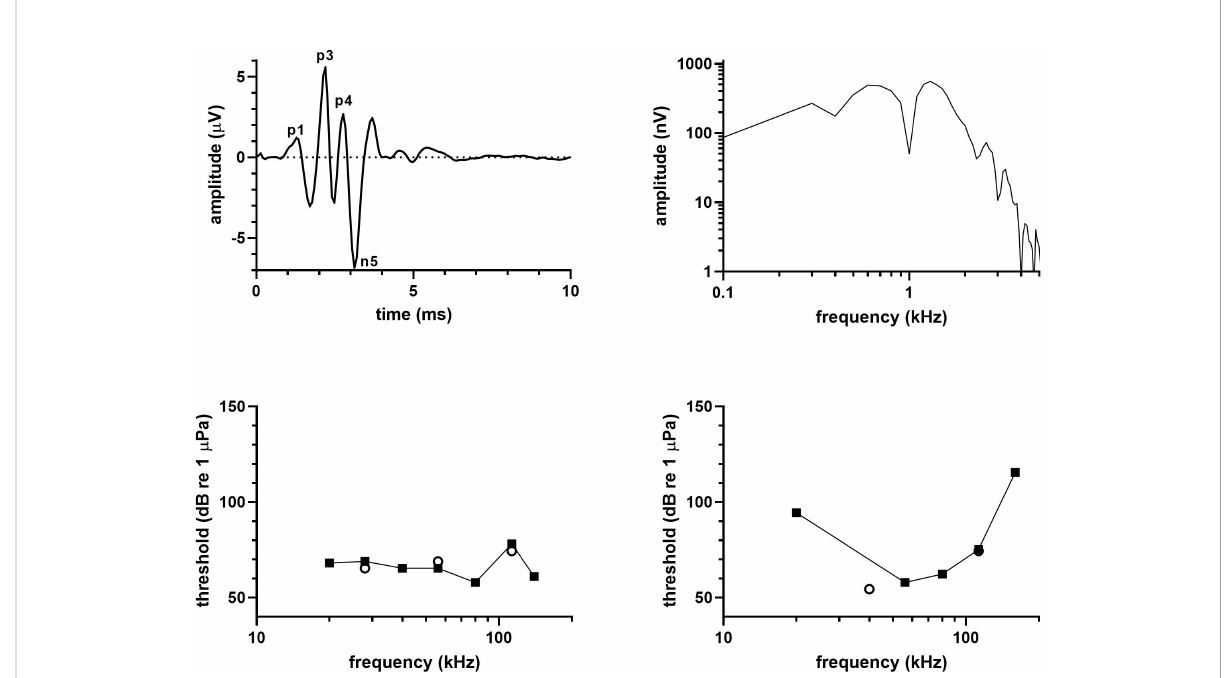
FIGURE 5 (top left) Click-evoked ABR, (top right) frequency spectrum of the ABR waveform, and (bottom left) audiogram for a long-beaked common dolphin (Dc1304b). (bottom right) Audiogram for an additional long-beaked common dolphin (Dc1601b) for which click-evoked ABRs were not obtained. In both bottom panels, open circles correspond to spot-checks of threshold with the contact transducer placed on the opposite side of the mandible.